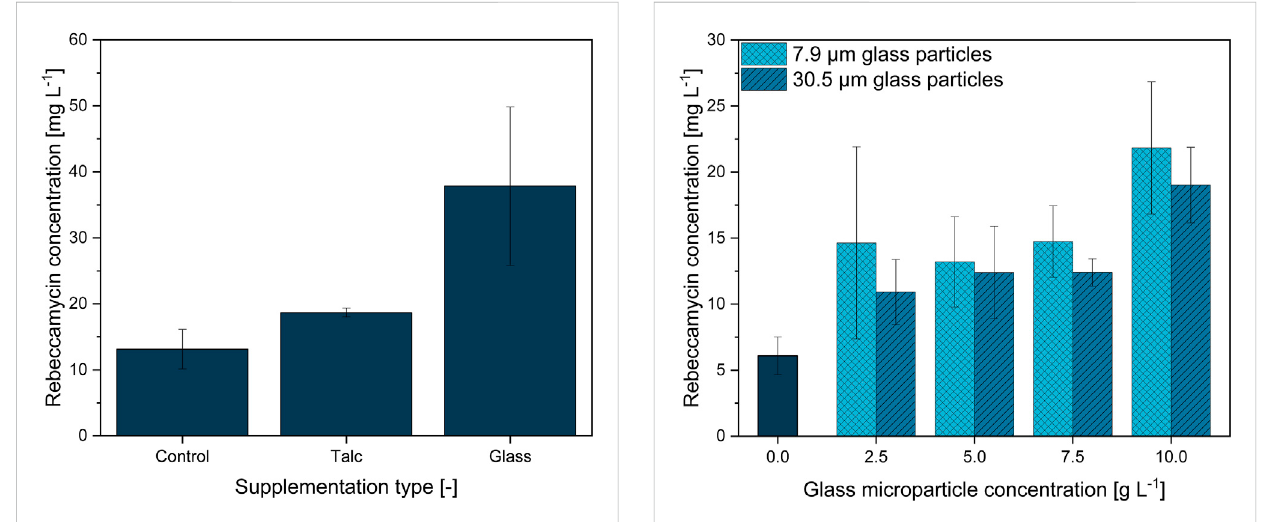
FIGURE 2 Rebeccamycin concentration of 10-day L. aerocolonigenes cultivation without microparticle addition (control) compared to cultivation with talc microparticle addition (10 g · L − 1 , 10 µm) and glass microparticle addition (10 g · L − 1 , x 50 = 7.9 µm).